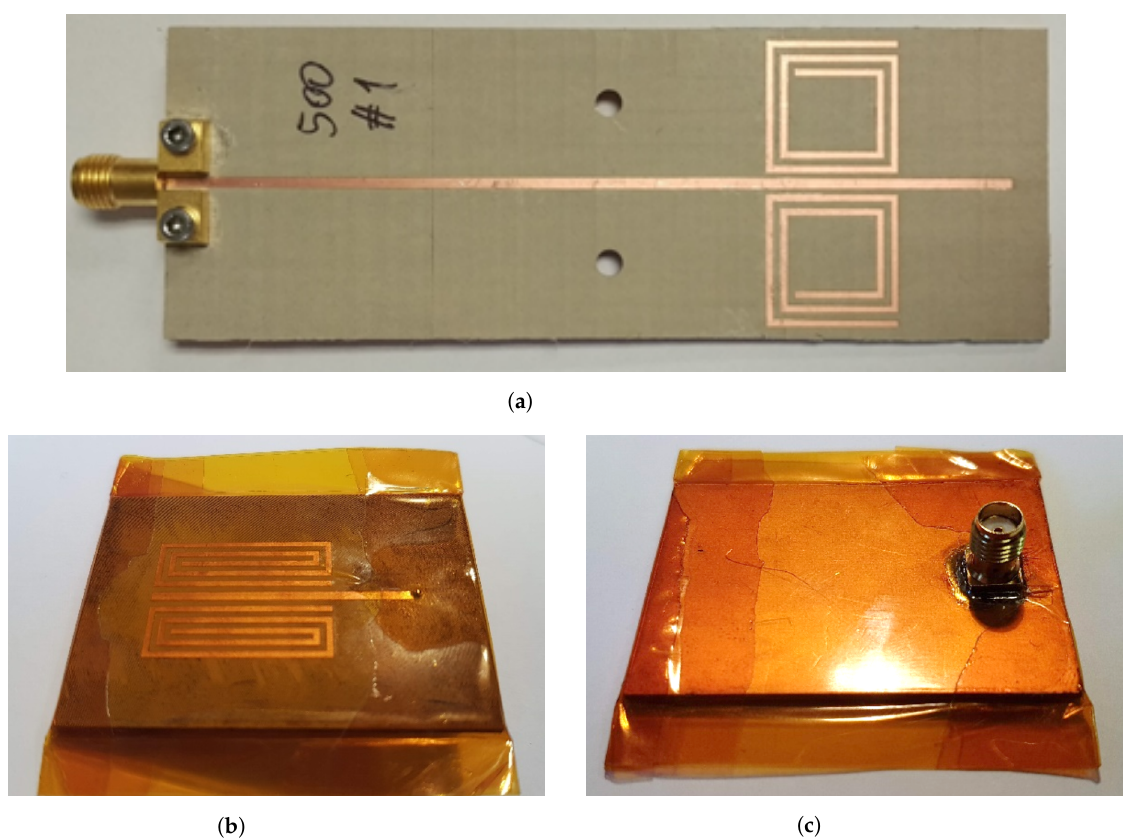
Figure 2. Manufactured A-type ( a ) SRR resonator-based sensor. B-type front ( b ) and back ( c ) view. Figure 3 sketches the B-type sensor. Each resonator has a length L SRR of 23 mm and a width W SRR of 7.2 mm. Both line widths W L and gaps G are 0.8 mm. The distance between the resonators and the microstrip line, D , is 0.93 mm. The microstrip line is 1.22 mm wide, which corresponds to a Z 0 = 50 Ω characteristic impedance. The resulting substrate dimensions, L × W , are 35 × 30 mm 2